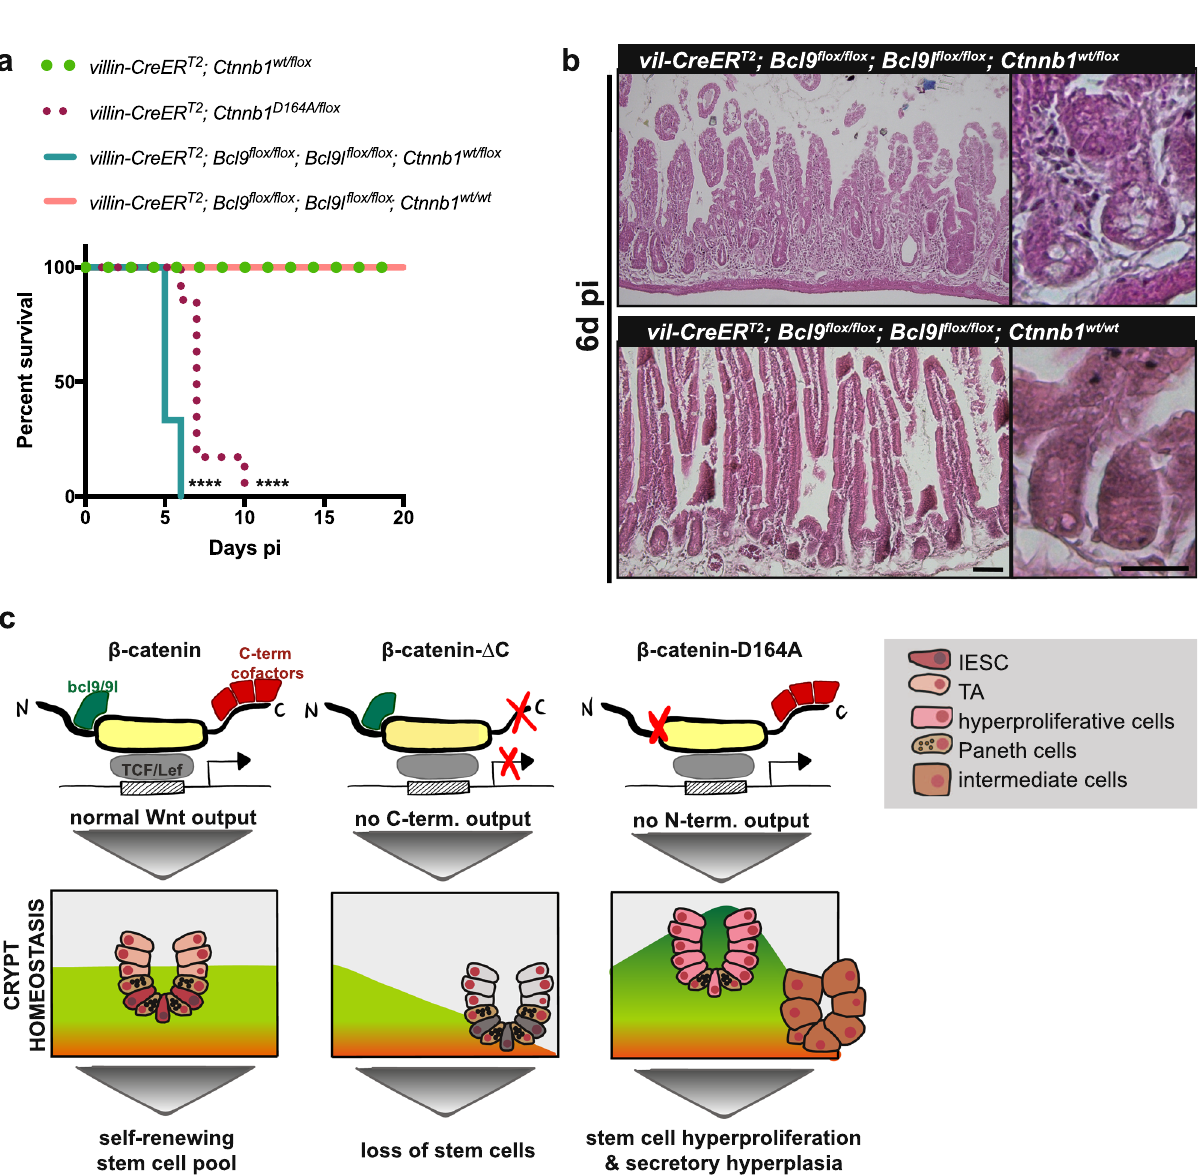
Fig. 7 Selective regulation β -catenin transcriptional outputs govern the identity of the intestinal epithelial stem cells. a Survival plot of villin-CreER T2 ; Ctnnb1 wt/ fl ox (control, n = 3), villin-CreER T2 ;Ctnnb1 D164A/ fl ox (D164A, n = 5), villin-CreER T2 ;Bcl9 fl ox/ fl ox ;Bcl9l fl ox/ fl ox ;Ctnnb1 wt/ fl ox ( n = 3) and villin-CreER T2 ; Bcl9 fl ox/ fl ox ;Bcl9l fl ox/ fl ox ;Ctnnb1 wt/wt animals ( n = 3). **** p < 0.0001 as calculated by two-sided log-rank (Mantel-Cox) test. b Histology sections of villin- CreER T2 ;Bcl9 fl ox/ fl ox ;Bcl9l fl ox/ fl ox ;Ctnnb1 wt/ fl ox and villin-CreER T2 ;Bcl9 fl ox/ fl ox ;Bcl9l fl ox/ fl ox ;Ctnnb1 wt/wt animals. Concomitant deletion of Bcl9, Bcl9L, and one copy of β -catenin induces crypt atrophy and villus shortening. Timepoint: 6d pi. Scale bar, 20 μ M. Representative images of three biological replicates. c Schematics of the proposed model. C-terminal co-activators govern basal Wnt signaling and preventing their activity leads to loss of stem cells and proliferative arrest. Contrary, N-terminal co-factors act as stem cell speci fi ers. Blocking their contribution results in hyperproliferation and aberrant differentiation of intestinal epithelial stem cells. IESC intestinal epithelial stem cell, TA transit ampli fi er